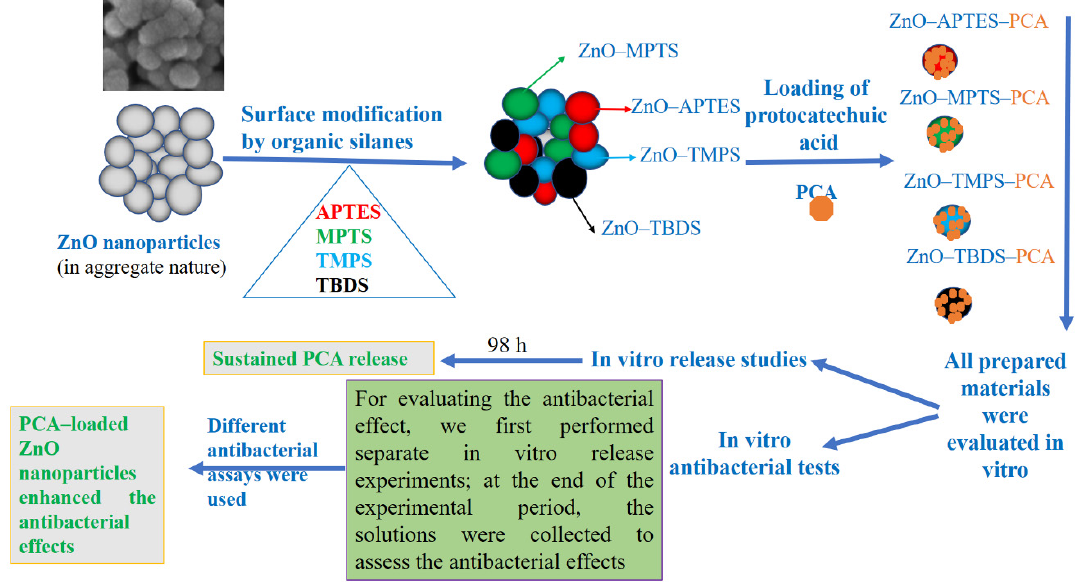
Scheme 1. Schematic representation of all synthesis stages and biological evaluations against bacteria for a delivery system for the PCA prodrug depending on ZnO NPs.